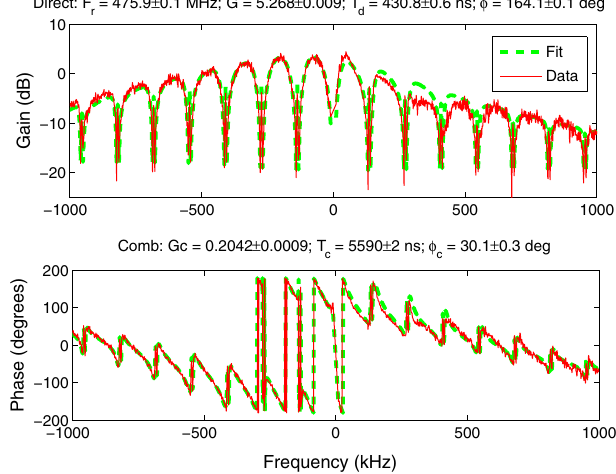
FIG. 3. (Color) Transfer function and parameters of operating station in LER at 1400